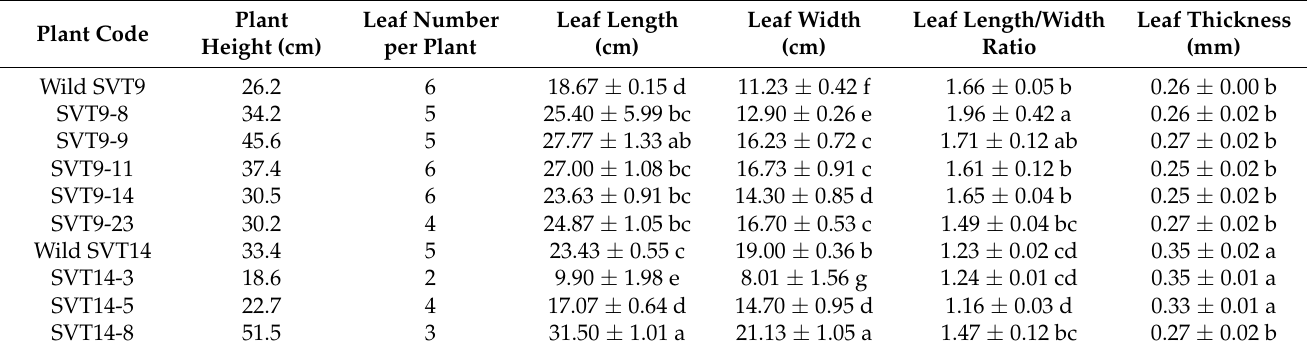
Table 2. Morphological characteristics of the in vitro-regenerated caladium variants and their corre- sponding wild type established in this